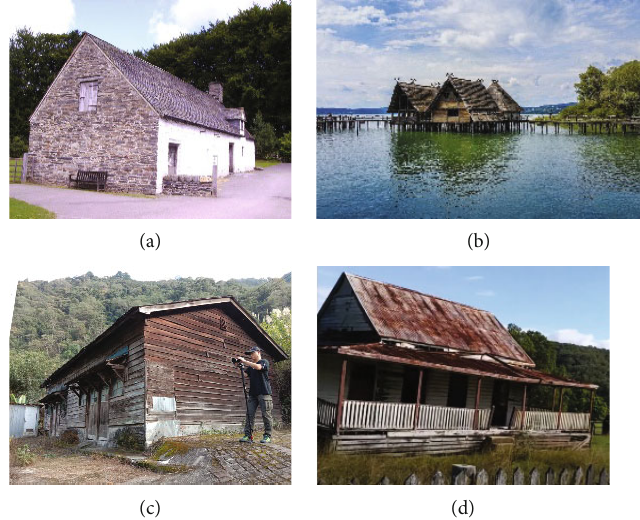
Figure 3: (a) The Dartmoor longhouse: Europe [11]; (b) stilt houses: Asia; (c) Central Taiwan; (d) Australia